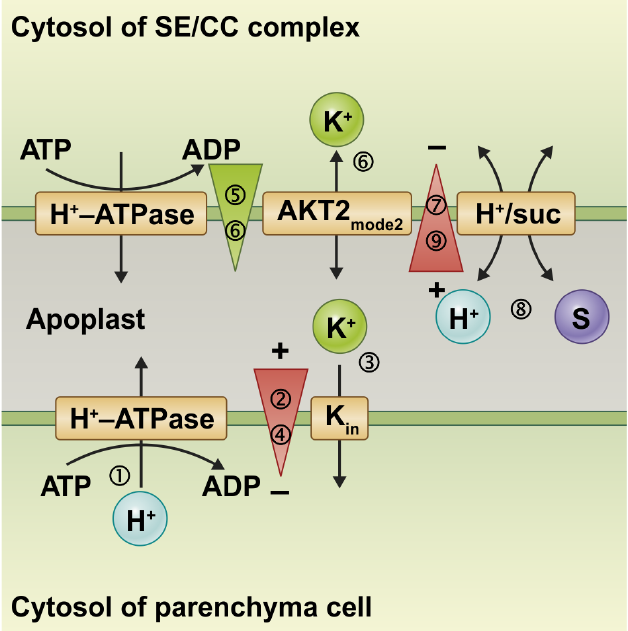
Figure 2. Electrochemical coupling allows remote control during phloem re-loading processes. See text for details. An animated version of this Figure can be found in the Supplementary Materials (Animation S1).